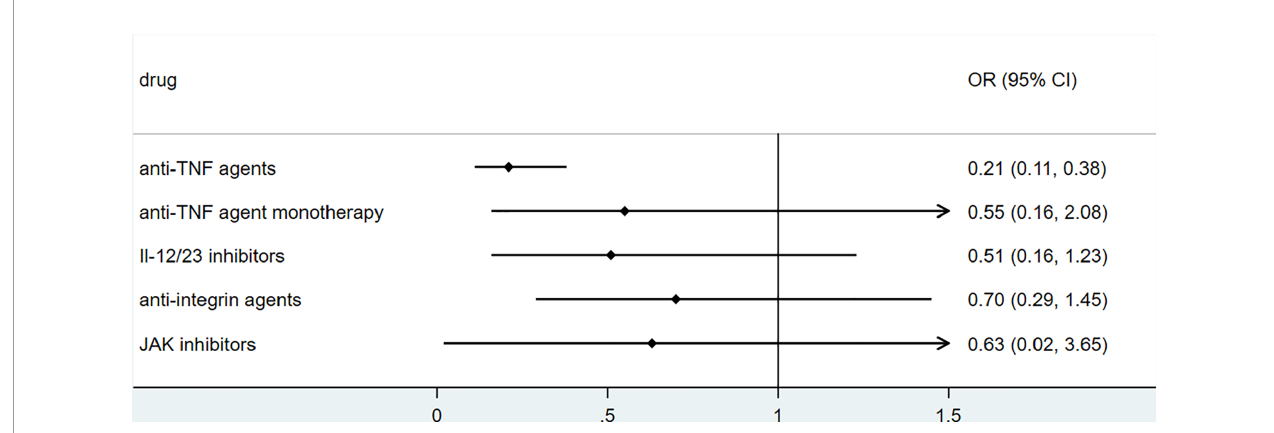
FIGURE 5 | The association of biologics and mortality rate among IBD patients with COVID-19 according to data from SECURE-IBD (27). [The group ‘ anti-TNF agent monotherapy ’ was compared to the group receiving anti-TNF agent combined with 6MP/AZA/MTX. The other groups ( ‘ Anti-TNF agents ’ , ‘ IL-12/23 inhibitors ’ , ‘ Anti-integrin agents ’ and ‘ JAK inhibitor ’ ) were compared to those did not receive the corresponding